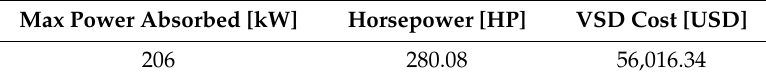
Table 2. Variable speed drive (VSD) cost estimation for Case 1.